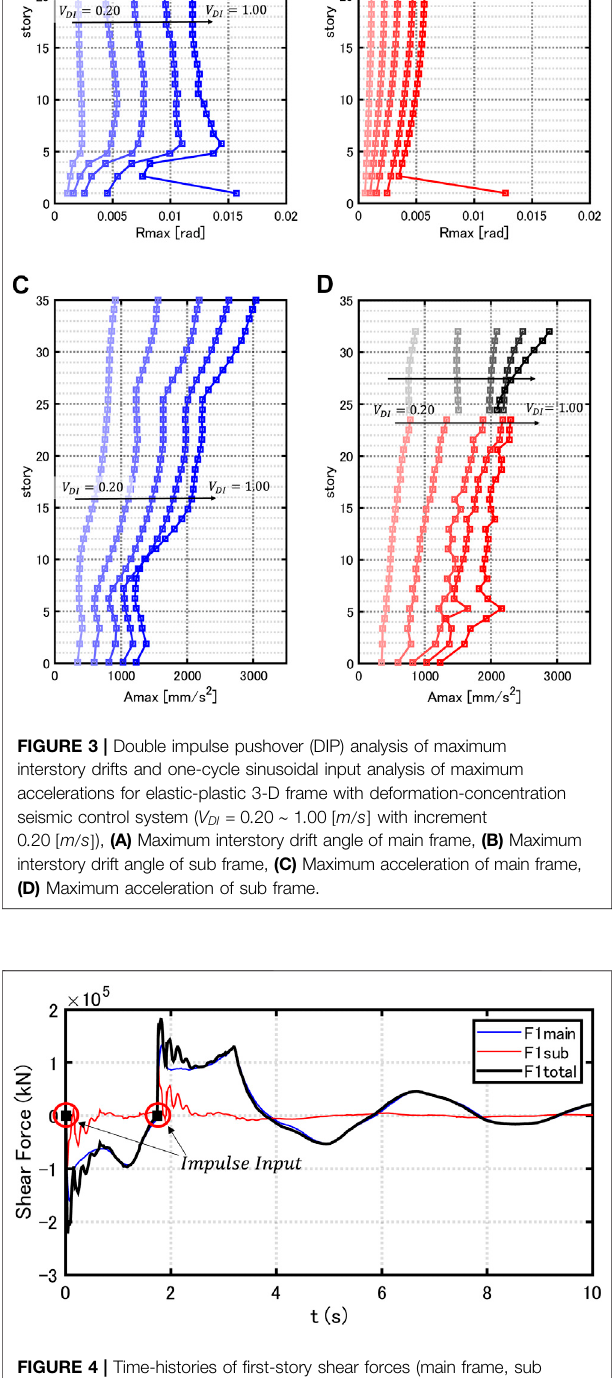
FIGURE 4 | Time-histories of fi rst-story shear forces (main frame, sub frame and total) and input timings of two impulses ( V DI (cid:1) 0 . 60 [ m / s ] ).